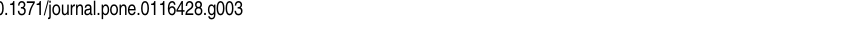
Fig. 3. Comparison of aroma compounds between Dayi Pu-erh tea and Ya’an dark tea samples. Different colors represent different kinds of volatile components.